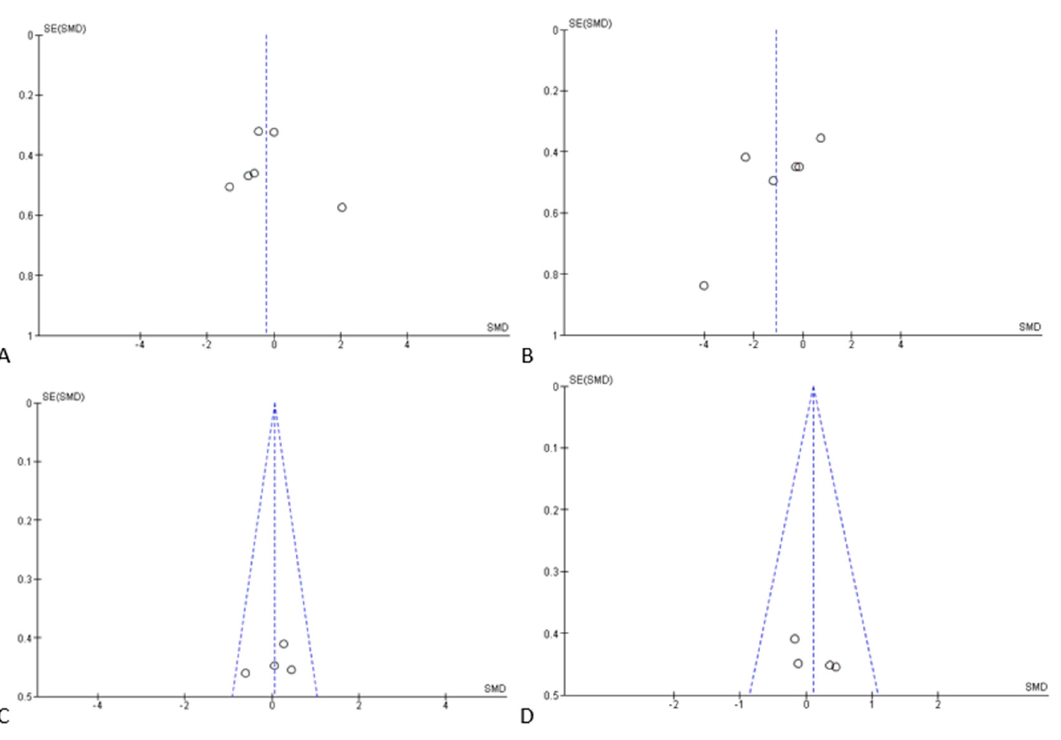
Figure 6. Funnel plots of the evaluation of heterogeneity for the ( A ) first, ( B ) second, ( C ) third, and ( D ) fourth outcomes.